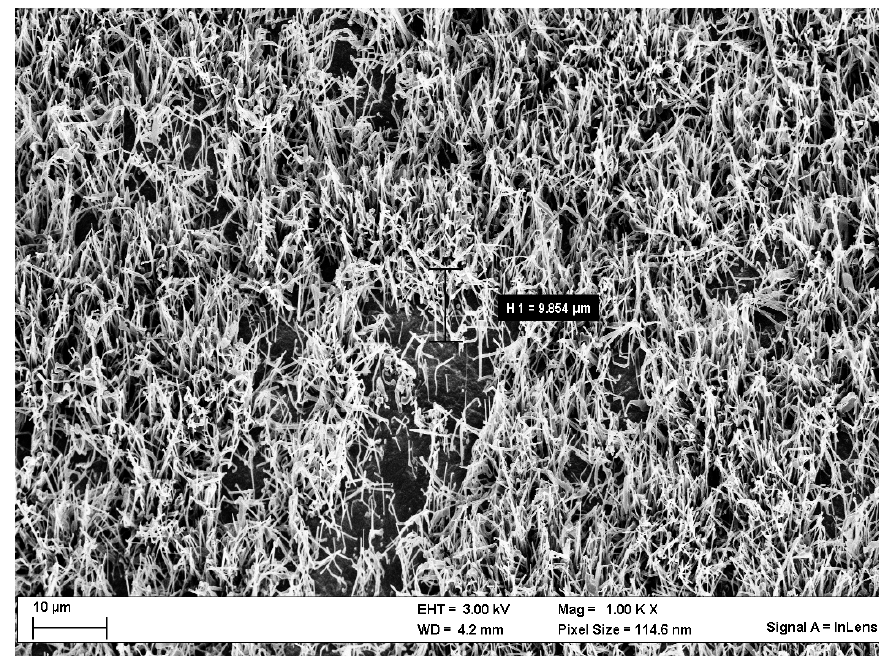
Figure 7. SEM image of lithium metal deposits on a copper foil, immediately after lithium deposition. Lithium was deposited for 360 s with a current density of 1 mA cm − 2 from 1 M LiDFOB in EC:DEC (3:7, by wt.). Additionally the measured height (9.854 µm) of the lithium metal deposits is shown.